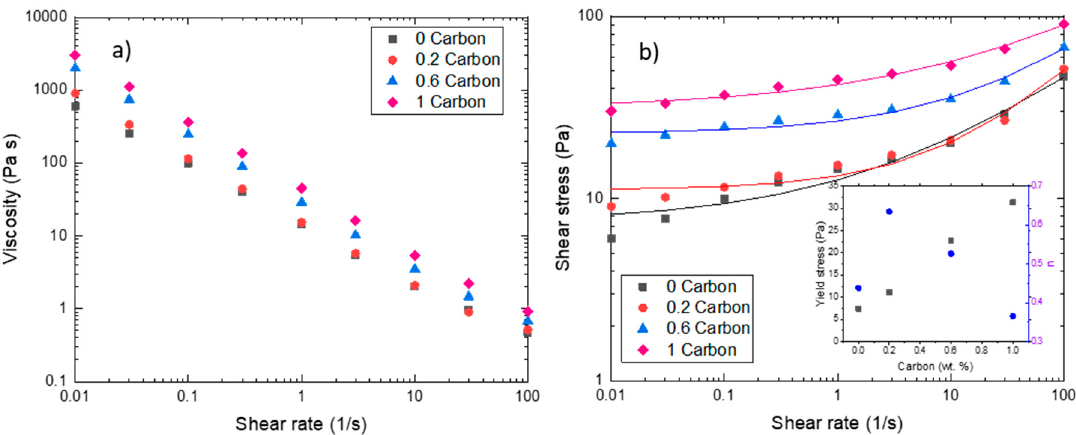
Figure 4. Steady-state rheometry. ( a ) Viscosity values vs. shear rate for carbon slurries. ( b ) Shear stress vs. shear rate for carbon slurries. Lines represents Herschel-Bulkley fitting. The inset in the graph shows the values of yield stress and flow index for all carbon slurries obtained from the fit.